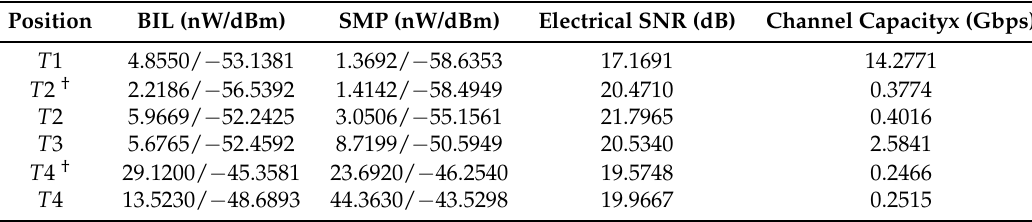
Table 4. Sniffing